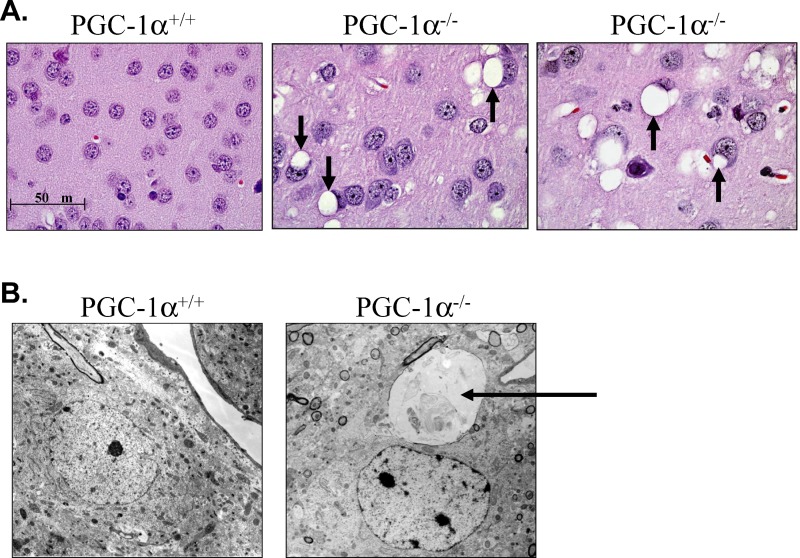
Neuropathology of the Central Nervous System of PGC-1α−/− Mice(A) Light microscopic appearance of representative cerebral cortex of 2-mo-old PGC-1α−/− mice demonstrates marked vacuolation of the neuropil (arrows) and scattered neuronal perikarya, which are absent in PGC-1α+/+ mice (hematoxylin and eosin). The scale bar shown is applicable to all sections.(B) Ultrastructural appearance of typical vacuoles containing membranous debris, denoted by the arrow, in the cerebral cortex of a representative PGC-1α−/− mouse in comparison to PGC-1α+/+ (magnification 4000×).